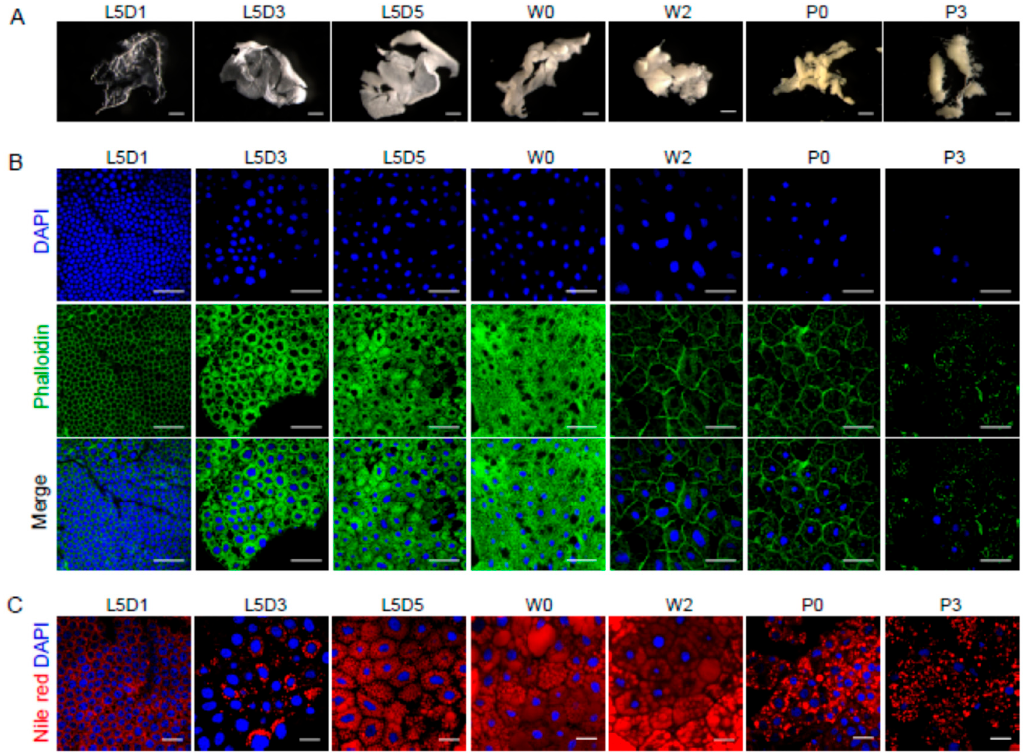
Figure 1. Morphological changes of cells and lipid droplets in the fat body during silkworm metamorphosis. ( A ) Dynamic changes in the morphology of the silkworm fat body. ( B ) Developmental changes in the cell shape of silkworm fat body cells. ( C ) Morphological changes of lipid droplets during the silkworm fat body remodeling. L5D1, the first day of the last larval instar; L5D3, the third day of the last larval instar; L5D5, the fifth day of the last larval instar; W0, just wandering; W2, the second day during wandering; P0, just pupation; P3, the third day after pupation. Blue, DAPI (nucleus); Green, Phalloidin (actin); Merge, DAPI and Phalloidin; Red, Nile red (lipid). Scale bars: ( A ) 2 mm, ( B ) 50 μ m, ( C ) 20 μ m.